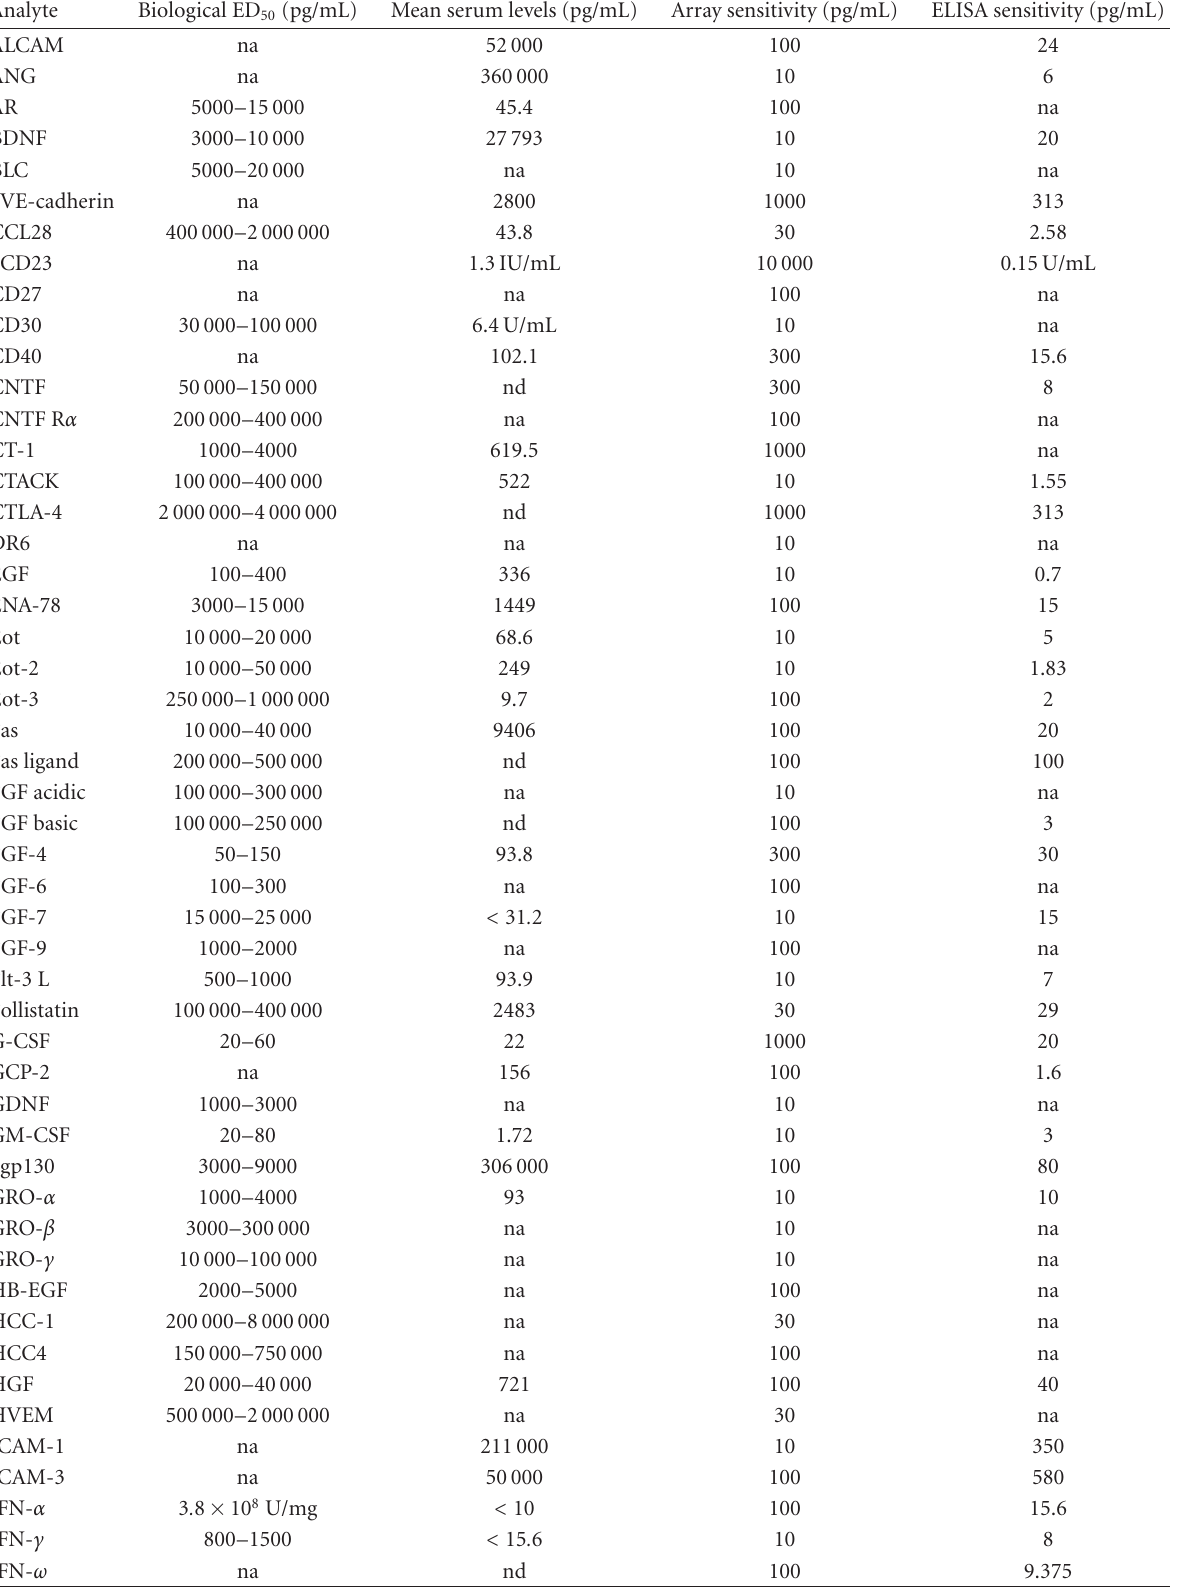
Table 1. Performance characteristics of the 150-feature protein